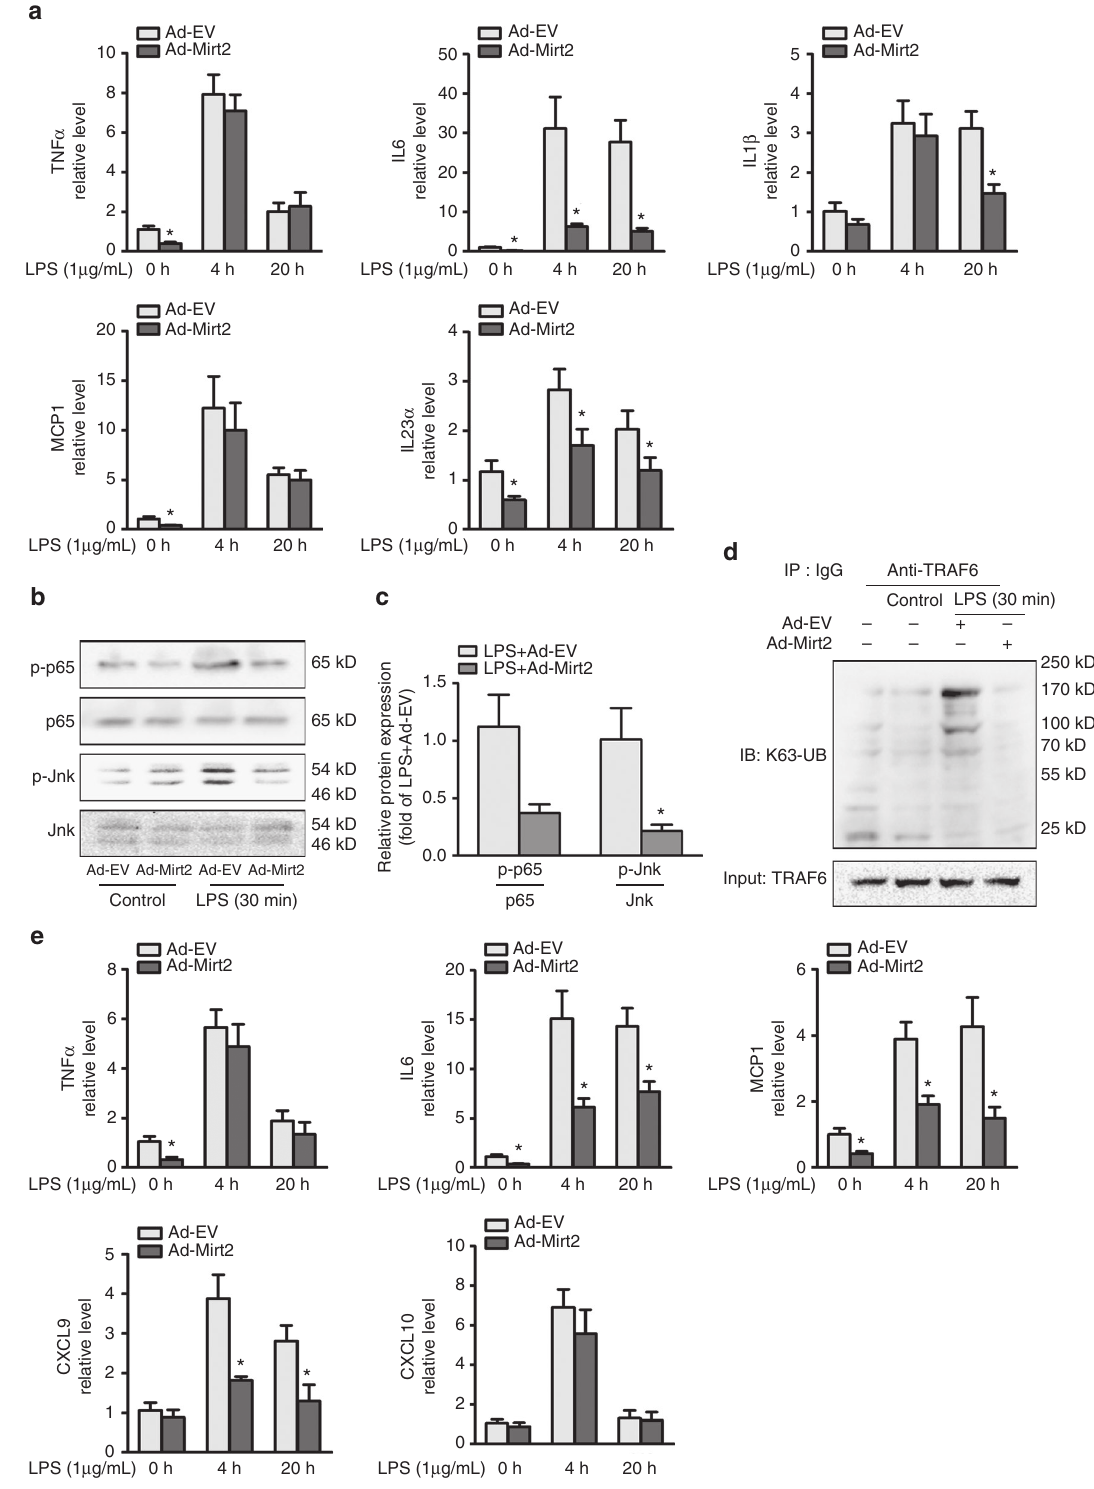
Fig. 7 Mirt2 has anti-in fl ammatory effects in tracheal epithelial cells and hepatocytes. a Effects of Mirt2 overexpression on the expression of in fl ammatory factors in tracheal epithelial cells, as determined by qRT – PCR. b Effects of Mirt2 overexpression on the phosphorylation of p65 and Jnk in tracheal epithelial cells, as determined by Western blot. c Quanti fi cation of band density in panel b . d Immunoblot analysis of the K63-linked ubiquitination of endogenous TRAF6 in Mirt2-overexpression tracheal epithelial cells treated with LPS, assessed after immunoprecipitation with TRAF6 antibody. e Effects of Mirt2 overexpression on the expression of in fl ammatory factors in hepatocytes, as determined by qRT – PCR. Data represent the mean ± SEM of three independent experiments. * P < 0.05 vs. Ad-EV group. Two-tailed Student ’ s t -test for two